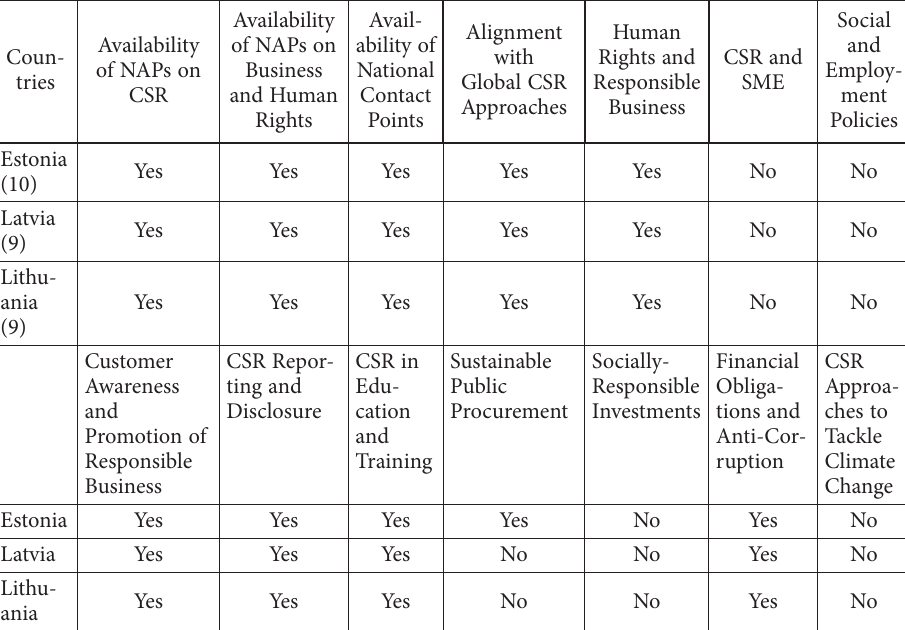
Table 3. Public policies to promote CSR in place in the Baltic States (source: created by the authors) Avail ability Avail- Alignment Human Availability of NAPs on ability of Coun- with Rights and of NAPs on Business Natio nal tries Global CSR Responsible CSR and Human Contact Approaches Business Rights Points